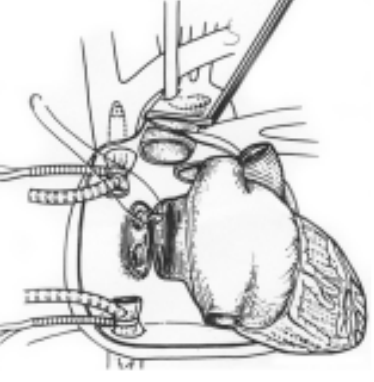
Fig. 4 – Anastomosis with the right pulmonary vein